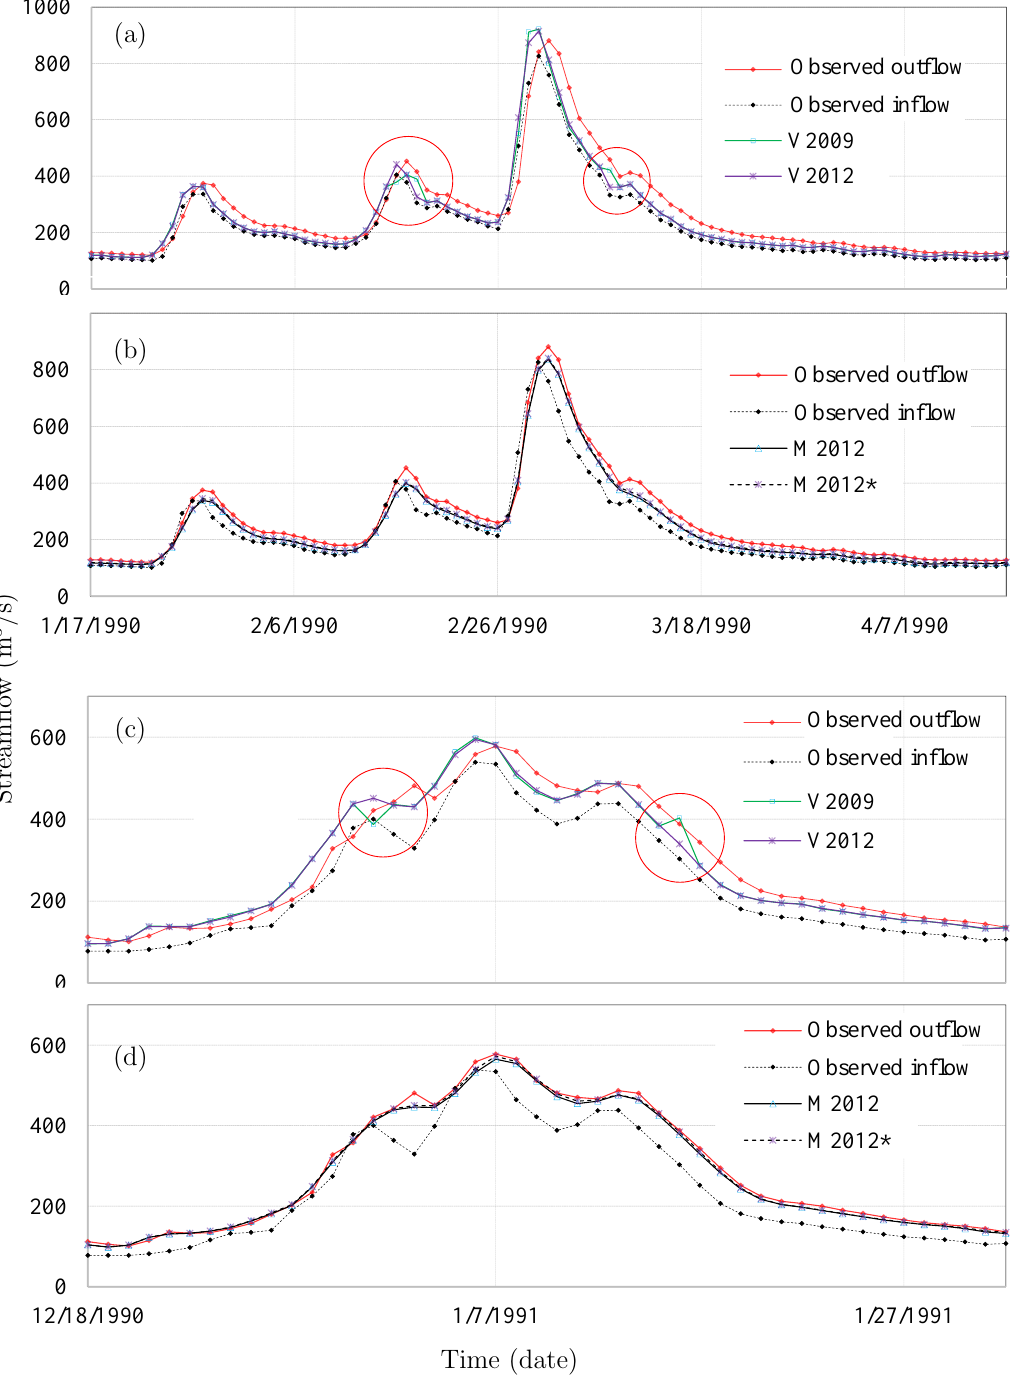
Figure 2. Simulated outflow at the Vlotho gauging station for two flood events using ( a , c ) V2009 and V2012 and ( b , d ) M2012 and